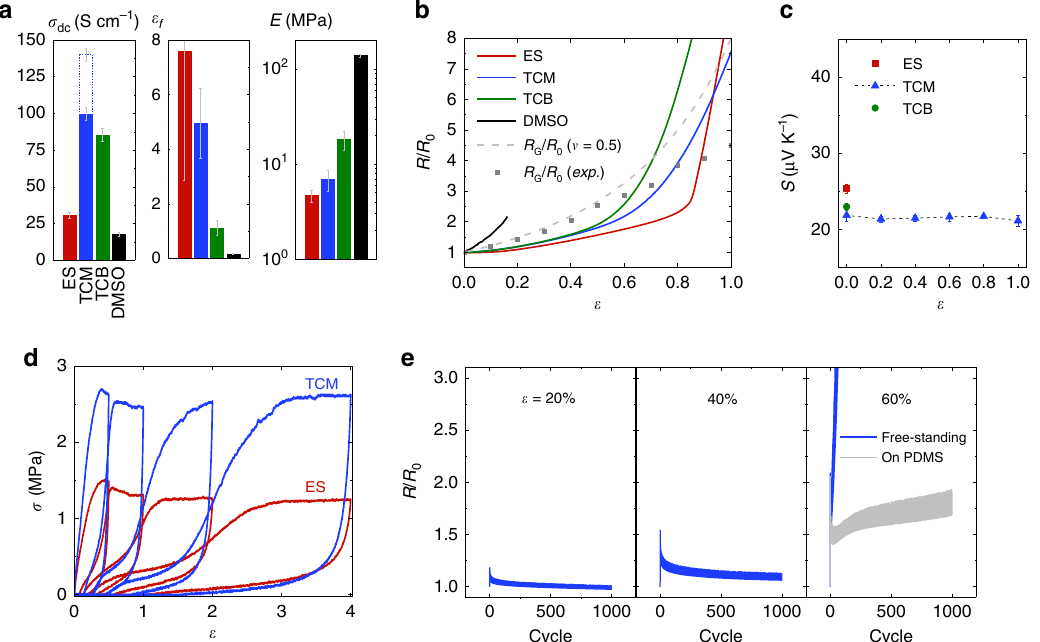
Fig. 3 Strain dependence of the properties. a Comparison of σ dc , ε f , and E of the composites with a different type of ILs or dimethyl sulfoxide (DMSO). The dotted bar shows the stabilized σ dc (see Supplementary Fig. 7). b Resistance change ( R / R 0 ) upon tensile stretching. Resistance change caused by geometrical shape changes ( R G / R 0 ) was plotted based on the typical Poisson ’ s ratio ( ν ) for rubber ( ν = 0.5) or the experimental data obtained for the composite (see Supplementary Fig. 5). c Initial S and S for tensile strain. d σ - ε curve upon cyclic loading. e R / R 0 of the optimized composite (CP:TCM:WPU = 15:25:85) upon cyclic tensile stretching (blue lines). R / R 0 of the optimized composite supported on a PDMS substrate under cyclic strain at 60% is also shown (gray line). Composition ratio, CP:IL:WPU = 15:25:85. For the composite with DMSO, 5.6 wt% of DMSO was added to the CP dispersion before making the composite. w/w for all composition ratios. Error bars represent the